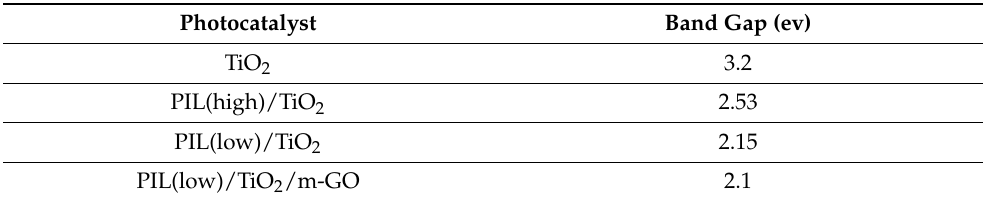
Table 1. Band gap of different